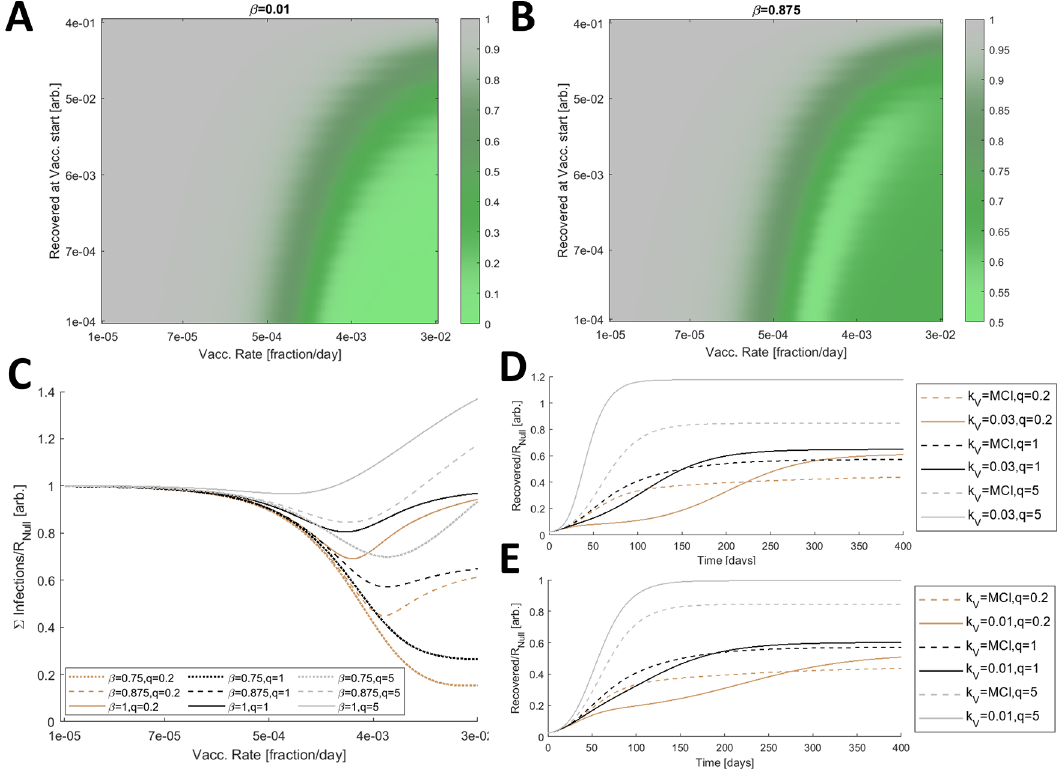
Figure 2. Optimal vaccine distribution. A. The cumulative number of infections relative to no vaccination, R Null , for a range of vaccine initiations and distribution rates. Here β is low, 0.01. B. The cumulative number of infectionsrelativetonovaccination, R Null ,forarangeofvaccineinitiationsanddistributionratesandalarge β (0.875). A/B. 3840 values were computed for each panel and 4 (cid:3) by 4 (cid:3) bilinearly interpolated points are displayed. Note that the color axis differs between A and B. C. The cumulative number of infections relative to no vaccination, R Null ,for β = [0.75(dotted),0.875(dashed),1(solid)]andthreerelativecontactrates, q= [0.2(brown),1(black),5(gray)]. D. Simulated epidemics comparing a high fixed rate of vaccination, k V = 0.03 (solid) representing the inoculation